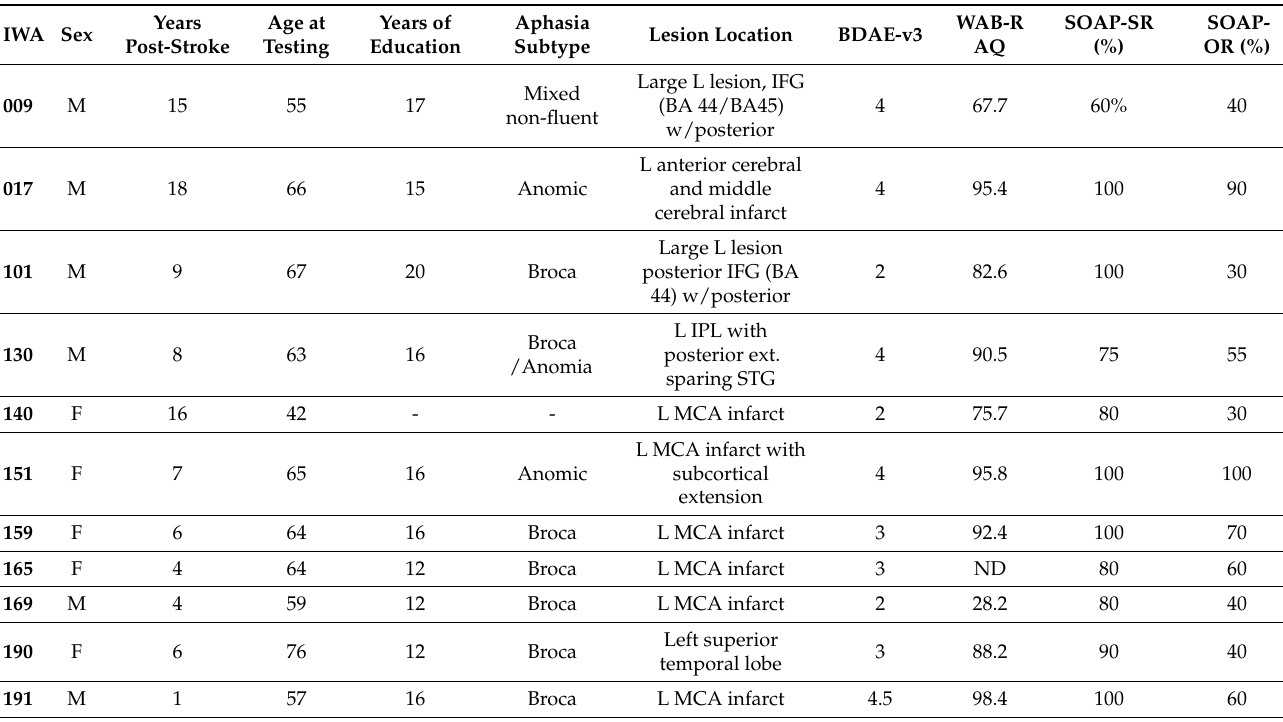
Table 2. IWA Participants’ characteristics ( n =